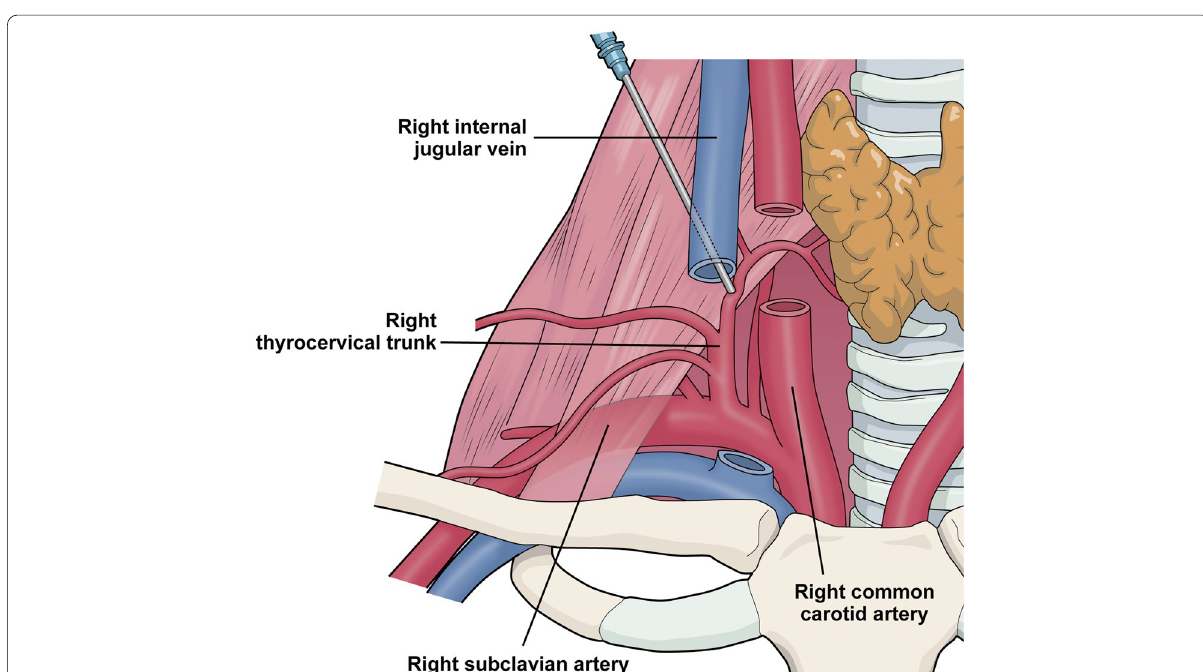
Fig. 3 Schematic image of right thyrocervical trunk injury. During the placement of a central venous catheter, the introducer needle crossed the lumen of the right internal jugular vein, causing an accidental puncture of the thyrocervical